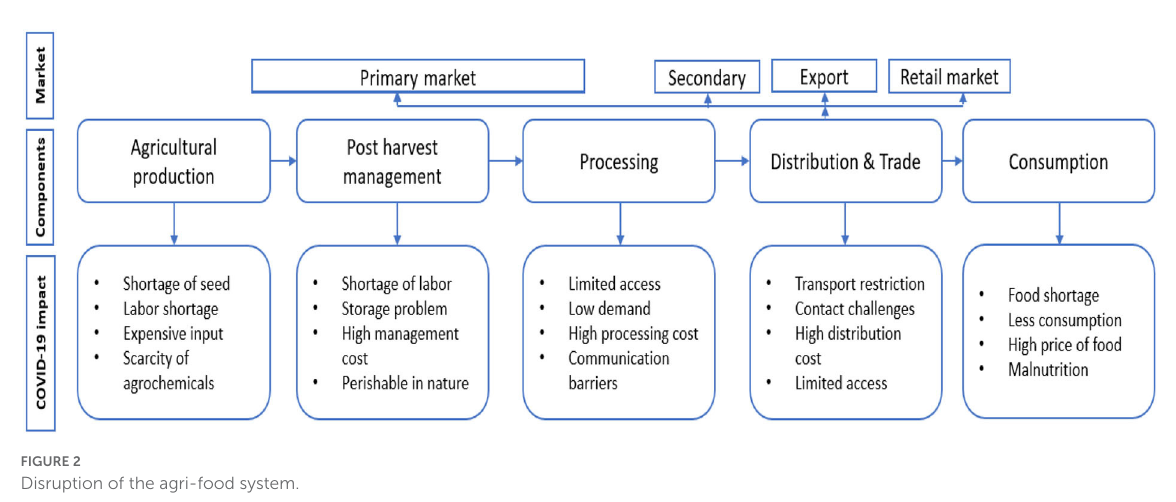
FIGURE2 Disruption of the agri-food